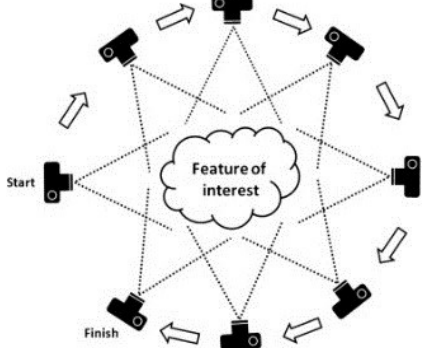
Figure 6: Example of the positions of the camera for multiple and overlapping photographs, to reconstruct scene geometry and camera motion (Westoby et al., 2012)